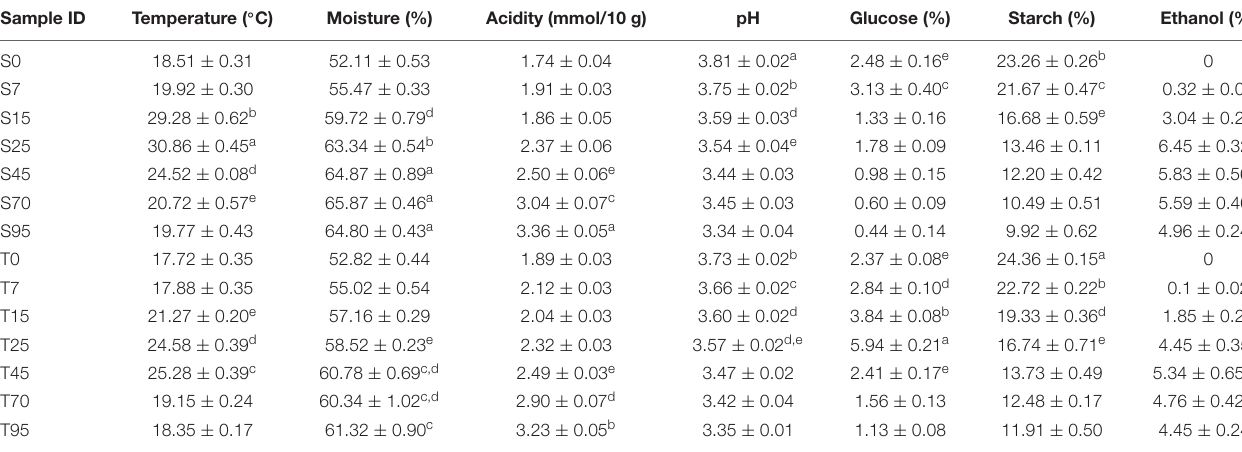
TABLE 1 | Chemical properties of FG during fermentation a .